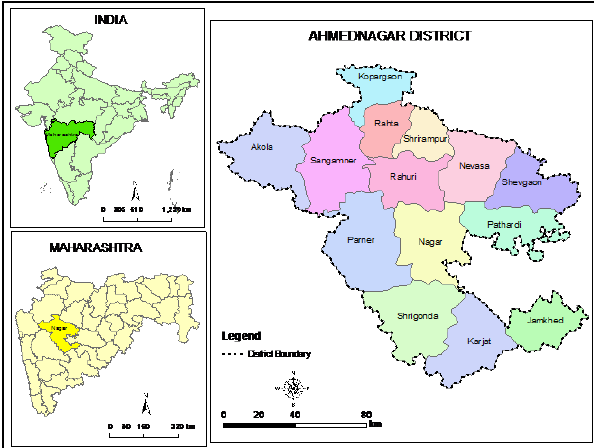
Figure 1. Location Map of Study